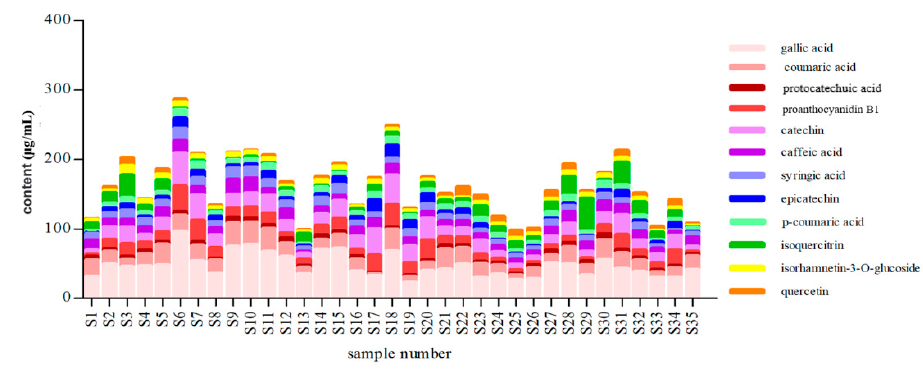
Figure 5. The content of 12 compounds from red wine ( n = 3).